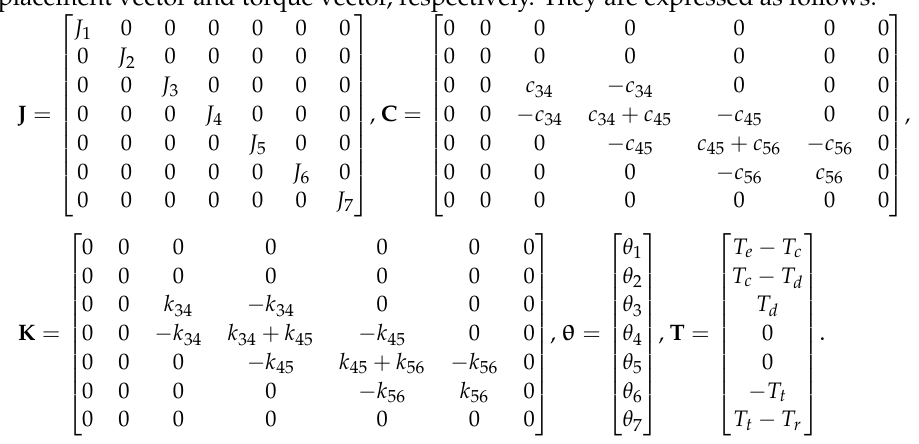
where 𝜔 is the angular velocity of crankshaft. The gas force 𝐹 (cid:3032)(cid:3034) and the inertia force 𝐹 (cid:3032)(cid:3036) applied to piston are: